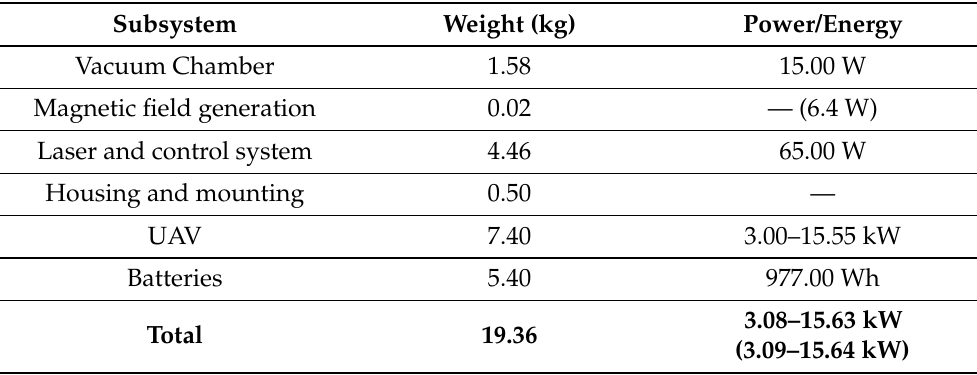
Table 1. The weight and power budget of the UAV with the portable compact MOT system in flight. The brackets show the effect of running the system with coils instead of magnets has on the power consumption of the system.